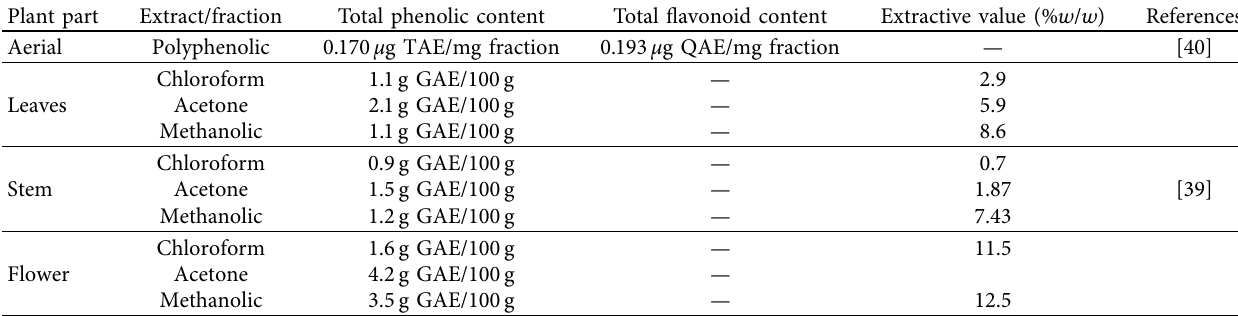
Table 2: Quantitative phytochemical content in R.